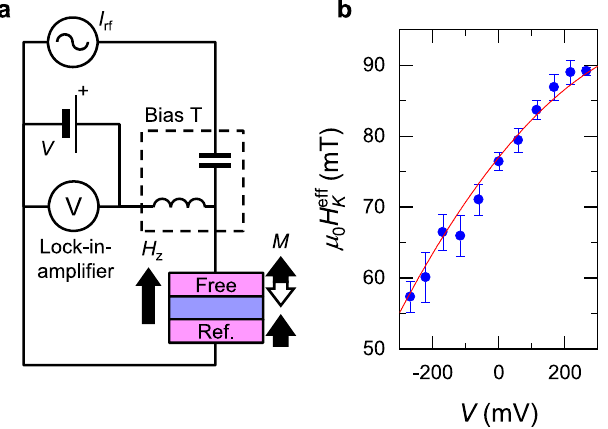
Fig. 2 Homodyne-detected ferromagnetic resonance. a Electrical circuit for homodyne-detected ferromagnetic resonance (FMR). b DC bias voltage V dependence of effective anisotropy fi eld ( μ 0 H K eff ) determined by FMR. Red curves are fi tting with a quadratic function to the plots. The error bar shows the standard error of fi tting Kittel ’ s resonant condition to the experimentally obtained resonant frequency versus perpendicular magnetic fi eld H z .